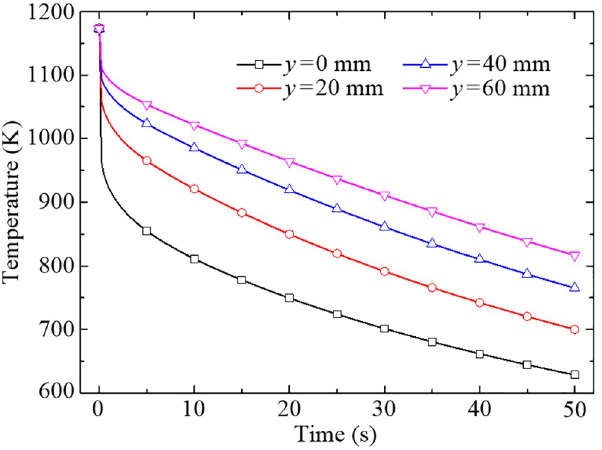
Fig 12. Temperature drops of the four representative points at the conjugate interface in 50 s.